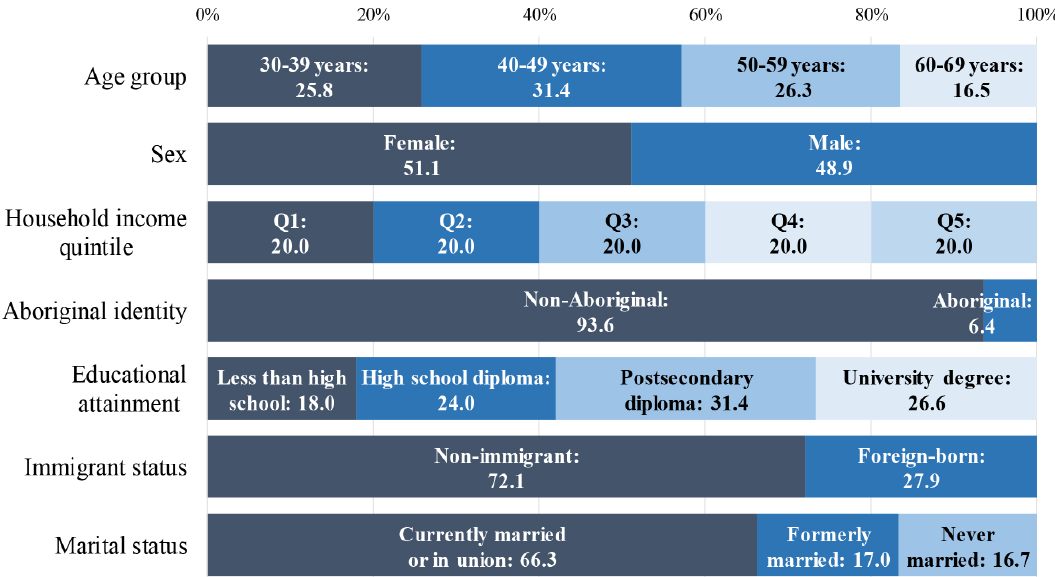
Figure 1: Distribution by sociodemographic characteristics of the 2006 Canadian census population aged 30–69 years